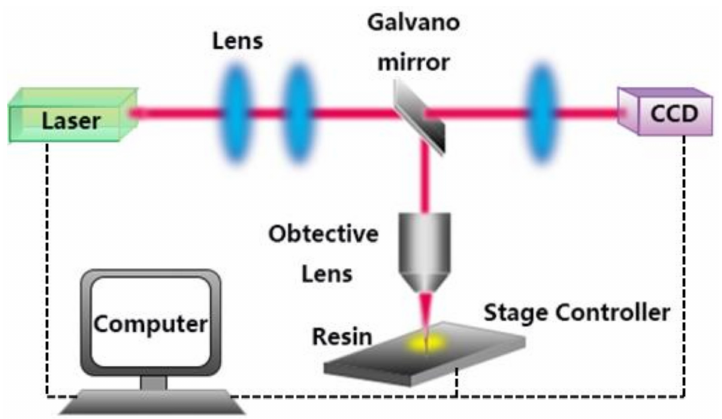
Figure 1. Schematic diagram of a DLW